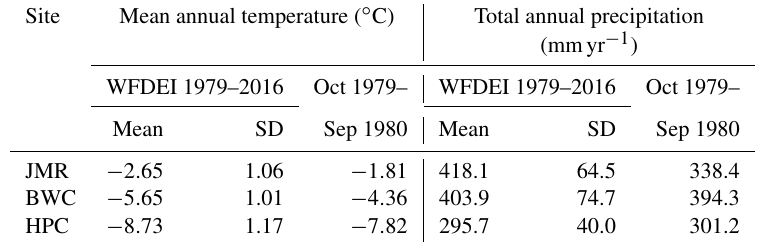
Table 4. Comparison of temperature and precipitation of the selected spinning year to mean climate of the WFDEI Dataset.